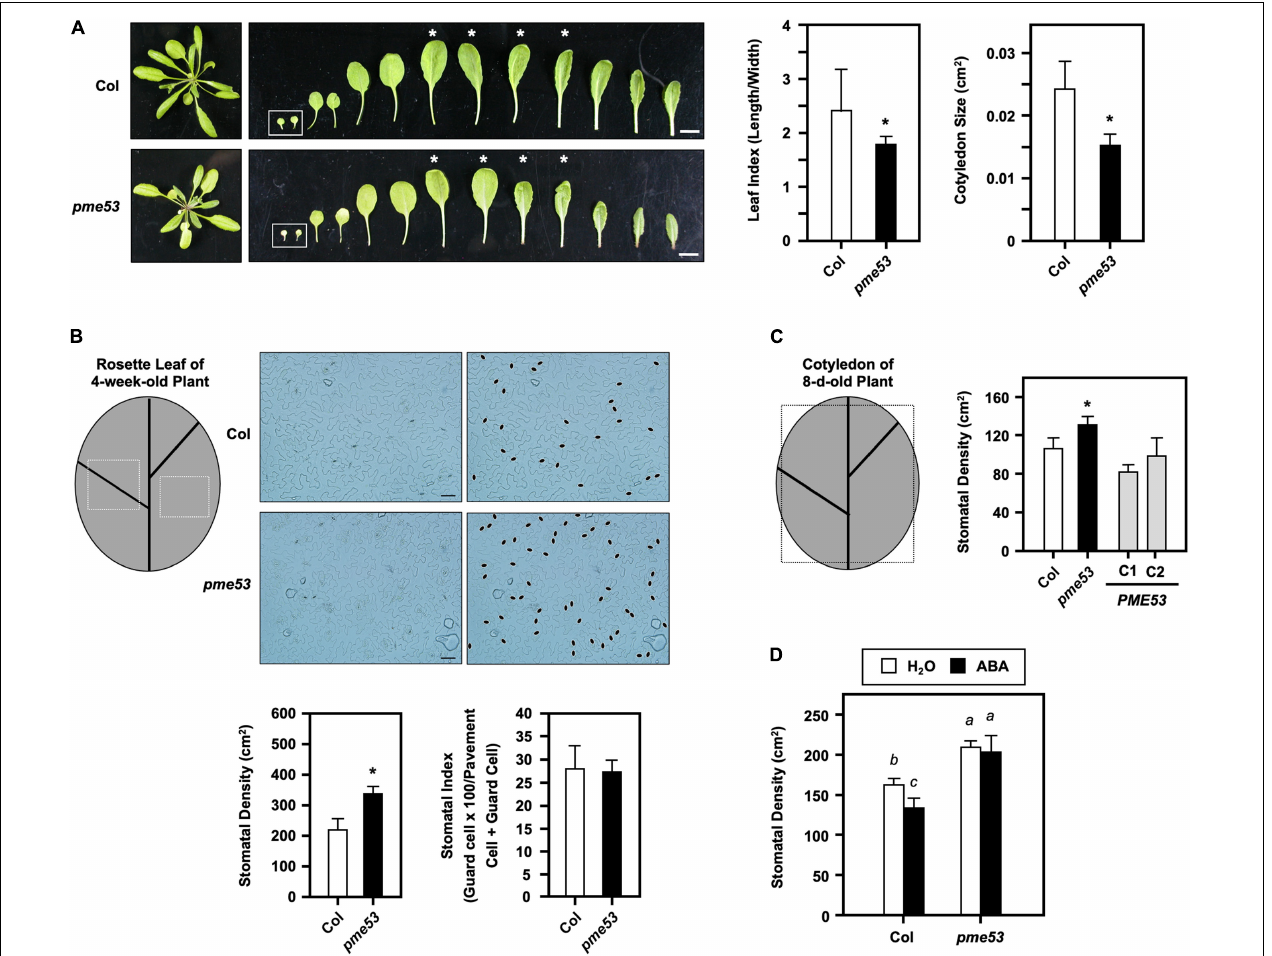
FIGURE 4 | Phenotyping of pme53 mutant plants. (A) 4-week-old plants and leaves were photographed. Cotyledons are shown in the inset. Leaf index (length/width) was determined by the ratio of the length to width of the 3rd and 4th pair of rosette leaves (asterisk indicated) and the size of the 7-day-old cotyledon (cm 2 ) was measured. n = 50 cotyledons. Bars = 1 cm. (B) Epidermal cells on the abaxial surface of 3rd and 4th pair leaves of 4-week-old plants were photographed. Stomata were highlighted in black ovals. Bars = 50 µ m. Stomatal density (stomata/cm 2 ) and stomatal index (guard cell × 100/pavement cell + guard cell) were measured. (C) Stomatal density in the abaxial surface of the cotyledon of 8-day-old plants were measured. PME53 -C1 and -C2 are PME53 -complemented lines generated in pme53 background. The frames are indicated that the regions used for the stomatal density measurement. *Significant at P < 0.05 compared with the Col. n > 10 leaves and cotyledons. (D) Seedlings were grown together then applied with H 2 O (control) or 2.5 mL 10 µ M ABA, at day 4 after planting. Stomatal development (stomatal/cm 2 ) in cotyledons was analyzed on day 7. Data are mean ± SE of three biological replicates. n > 10 cotyledons. Statistical significances among groups are indicated using different letters (Tukey’s HSD test).